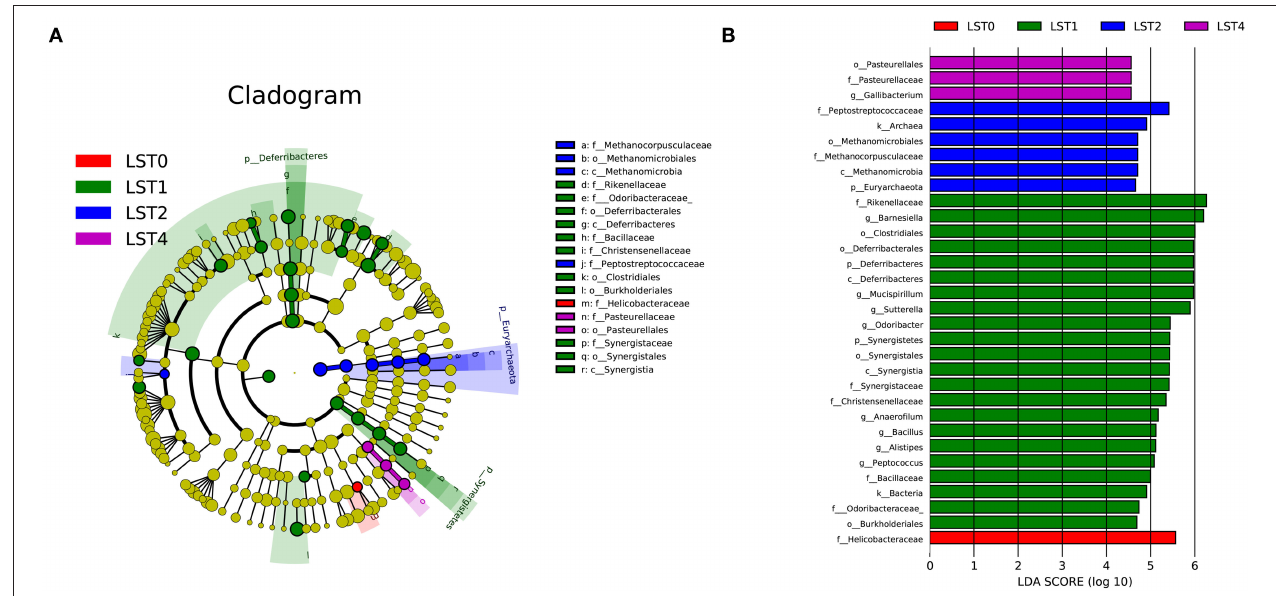
FIGURE 3 | Linear discriminant analysis (LDA) effect size (LEfSe) of cecal microbiota in broilers fed with LST powder at day 42. (A) Phylogenetic profile of specific bacterial taxa and predominant bacteria among the four different groups, as determined using the LEfSe analysis. Biomarker taxa are heighted by colored circles and shaded areas. Each diameter of circle is relative to abundance of taxa in the community. (B) Histogram of LDA score calculated for differential abundant taxa with cutoff LDA score > 2.0. LST, Lasia spinosa Thw.; LST0, control diet; LST1, 1% supplementation level of LST powder; LST2, 2% supplementation level of LST powder; LST4, 4% supplementation level of LST